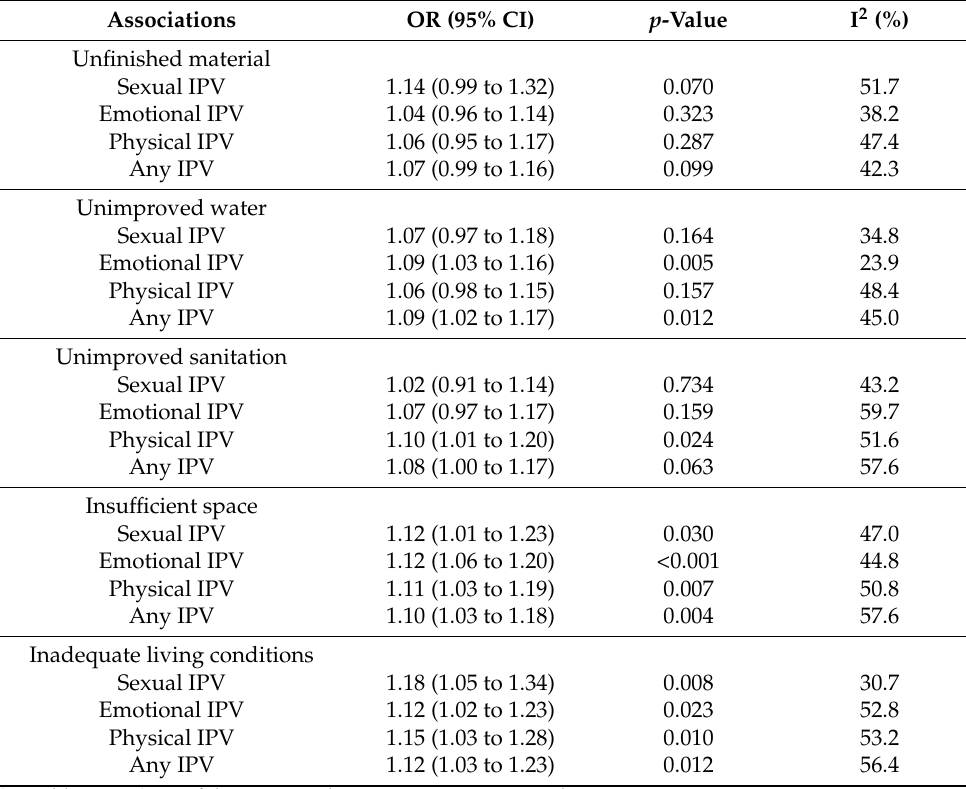
Table 4. Associations of housing characteristics with intimate partner violence.